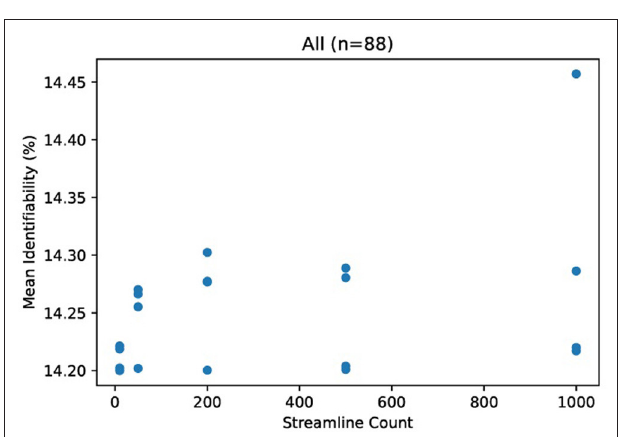
FIGURE 3 | Mean identifiability with all patients ( q = 4 random seeds per streamline count, k = 20 subset size, r = 10 repetitions). For each streamline count, there are q data points with tractography running a unique random seed. Each data point represents the average of r repetitions of k randomly selected patients in order to normalize for dataset